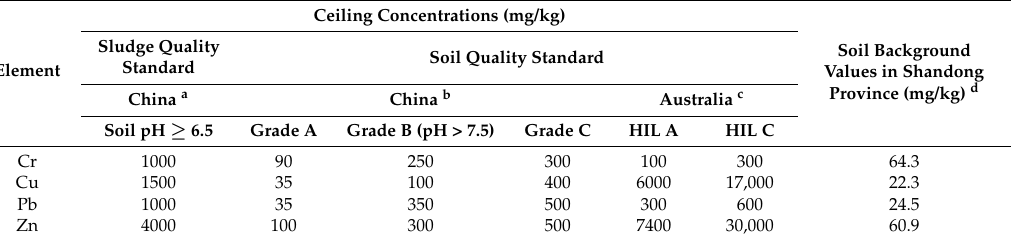
Table 3. Ceiling concentrations of the selected heavy metals in the sewage sludge quality standard for landscaping in China, soil quality standards in China and Australia, and soil background values in Shandong